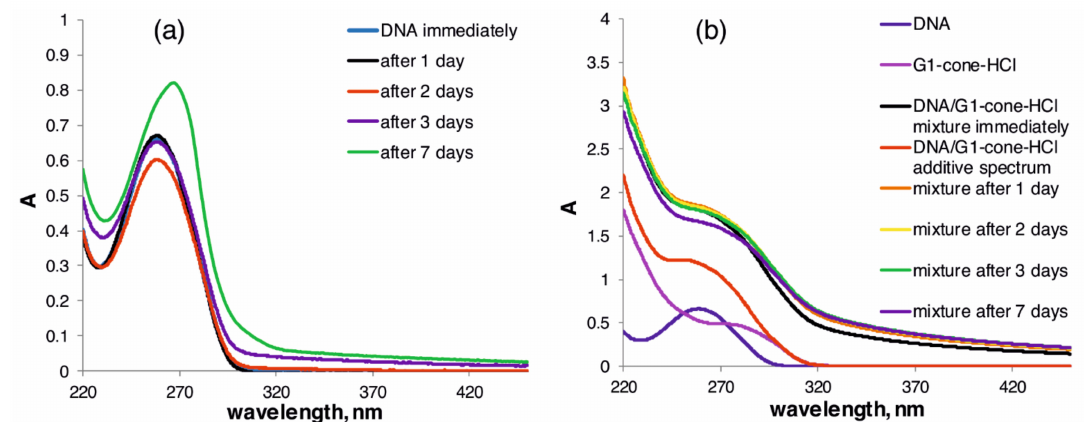
Figure 6. UV-Vis spectra of ( a ) pure DNA (3.710 × 10 − 5 M base pairs), ( b ) DNA (3.710 × 10 − 5 M base pairs) in the presence of G1-cone-HCl (10 mM Tris-HCl buffer, pH